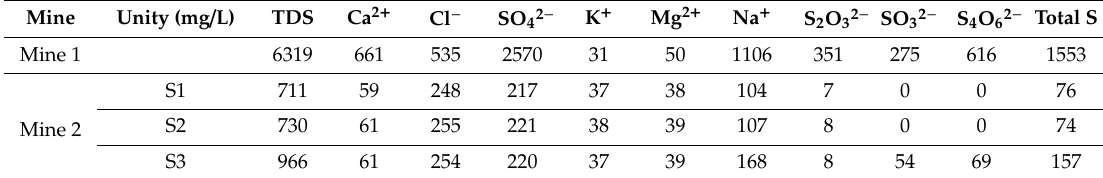
Table 4. Composition of the control samples for Mine 1 and Mine